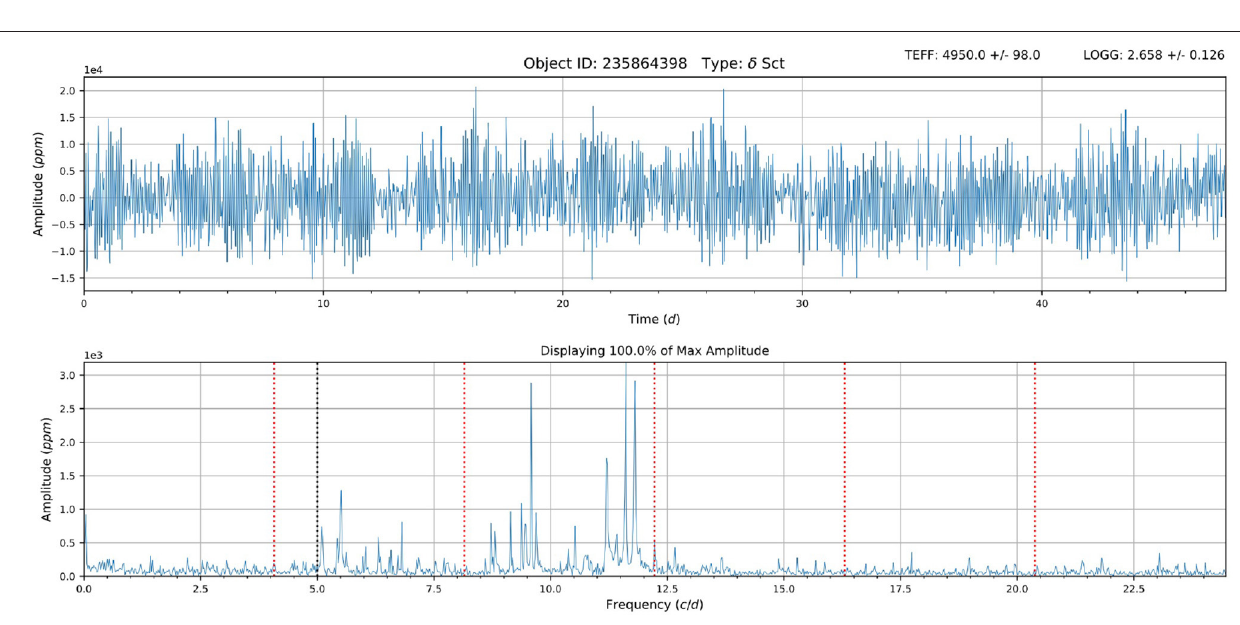
FIGURE 8 | Light curve (Top) and amplitude spectrum (Bottom) for the coolest δ Sct candidate, EPIC 235864398, observed during